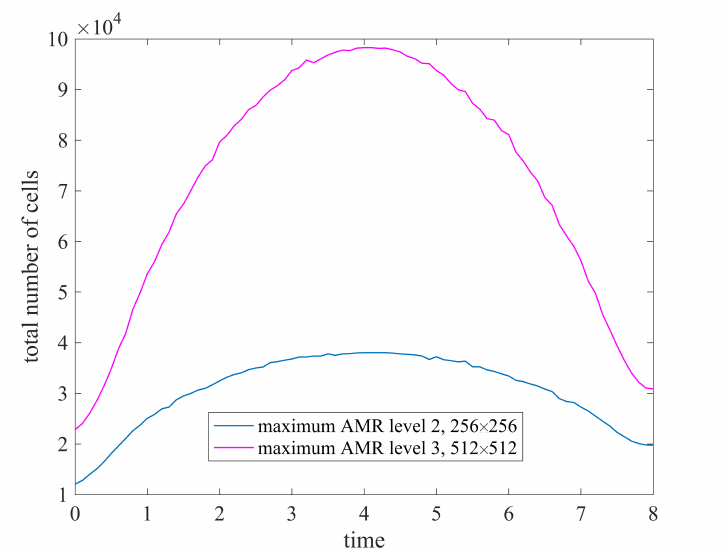
Figure 9. Time evolution of the total cell number on the AMR grid. Maximum AMR refinement level 2 with a finest resolution of 256 × 256 is shown in blue, and maximum AMR level 3 with a finest resolution of 512 × 512 is shown in pink.